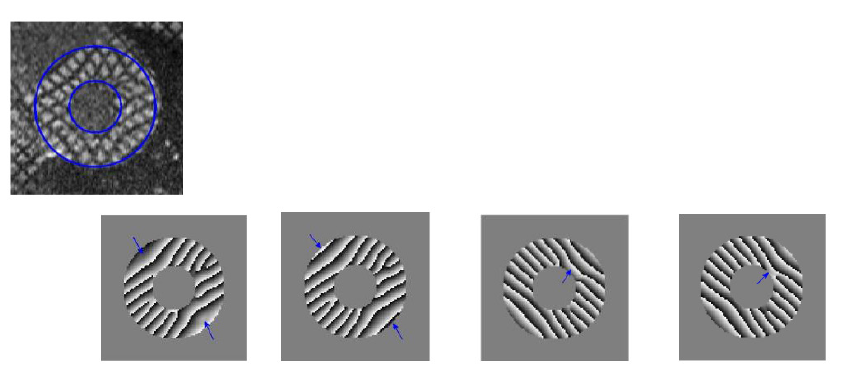
Figure 9: Top: Myocardial tagged image at end-systole, Bottom: Harmonic phase image in both directions, (a) and (c) before DC component subtraction, (b) and (d) after DC component